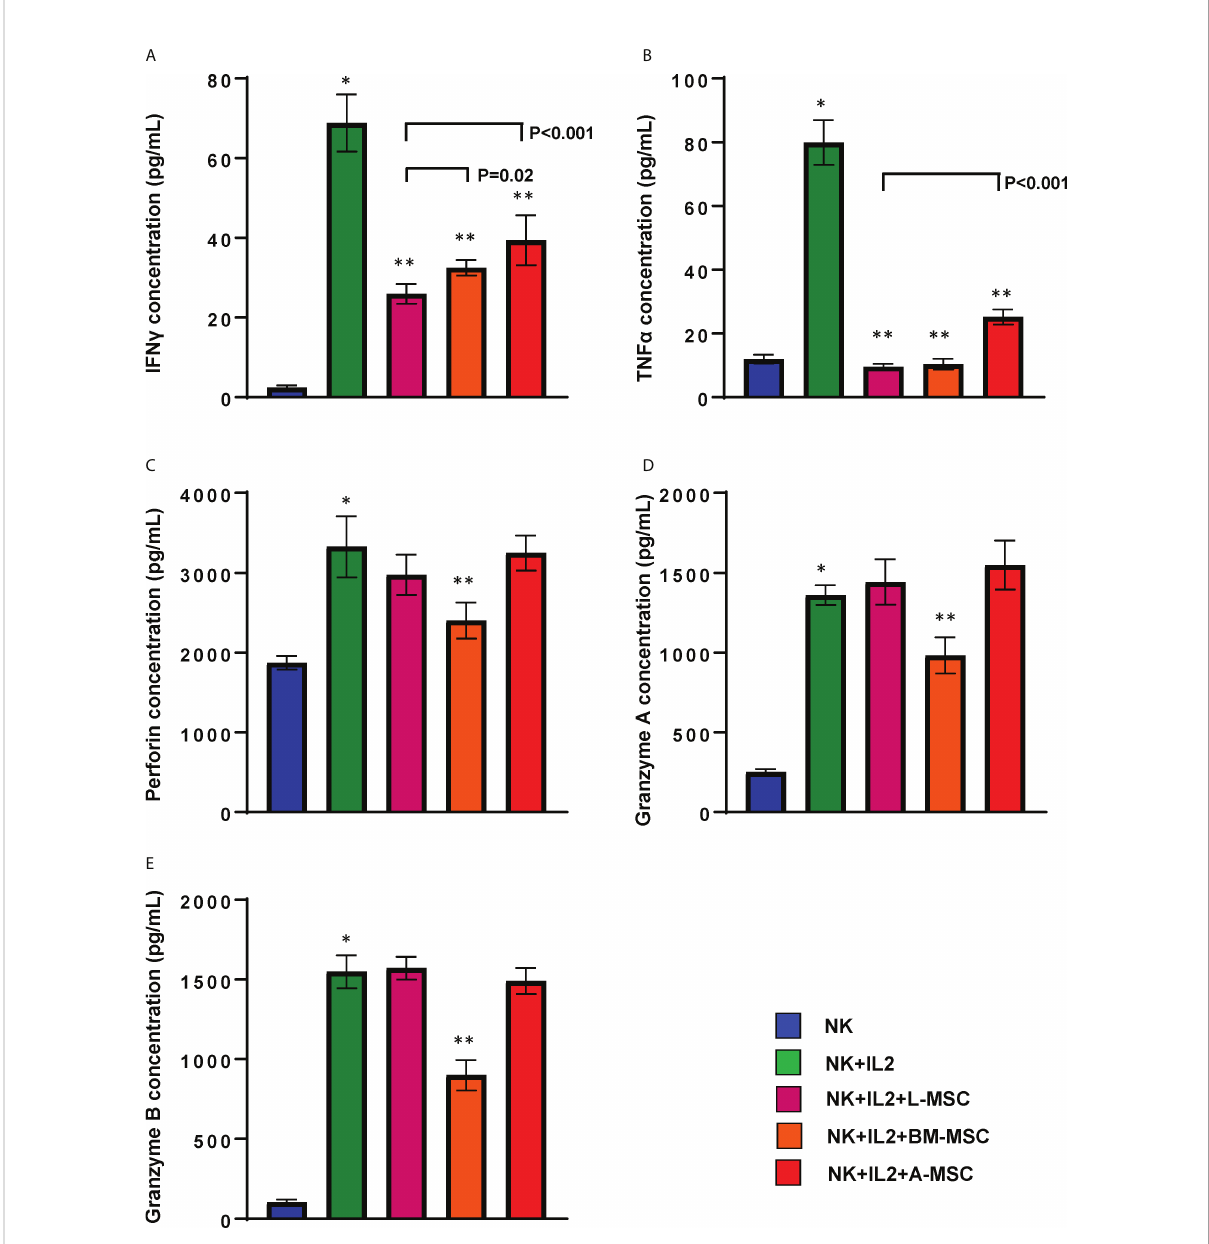
FIGURE 5 MSCs ’ modulation of cytokine secretion by NK cells. Following 3 days of co-culture with IL-2, supernatants were collected, and their IFN g (A) , TNF a (B) , Perforin (C) , Granzyme A (D) and Granzyme B (E) were measured using ELISA. Values are reported in pg/ml and represent the mean ± SD of 4 independent experiments, each performed in triplicates. Paired Student ’ s t-test was used for the statistical analysis. *P<0.001 vs. NK cells; **P<0.001 vs. NK+IL2. L-MSC, liver mesenchymal stromal cell; BM-MSC, bone marrow mesenchymal stromal cell; A-MSC, adipose mesenchymal stromal cell; NK, natural